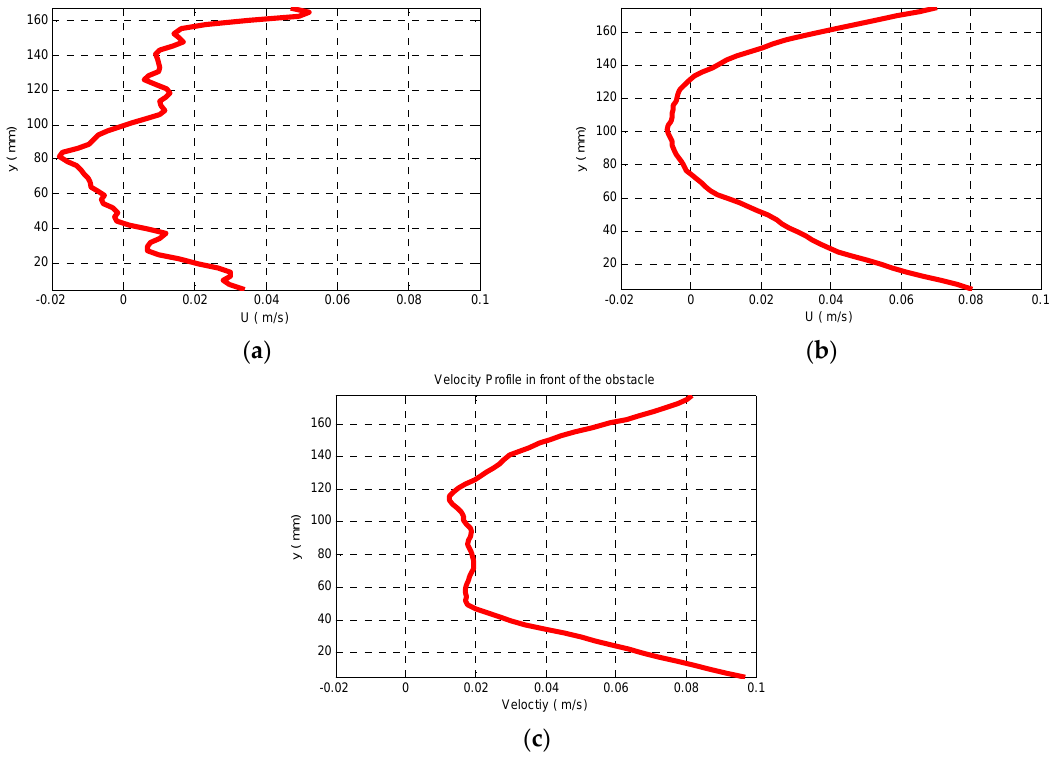
Figure 4. Velocity profiles downstream (position 2) in front of the second mussel shock, when the shocks are on the central axis of the channel, for distance between the shocks L = 500 mm and velocity ( a ) 5 cm/s, ( b ) 7 cm/s and ( c ) 9